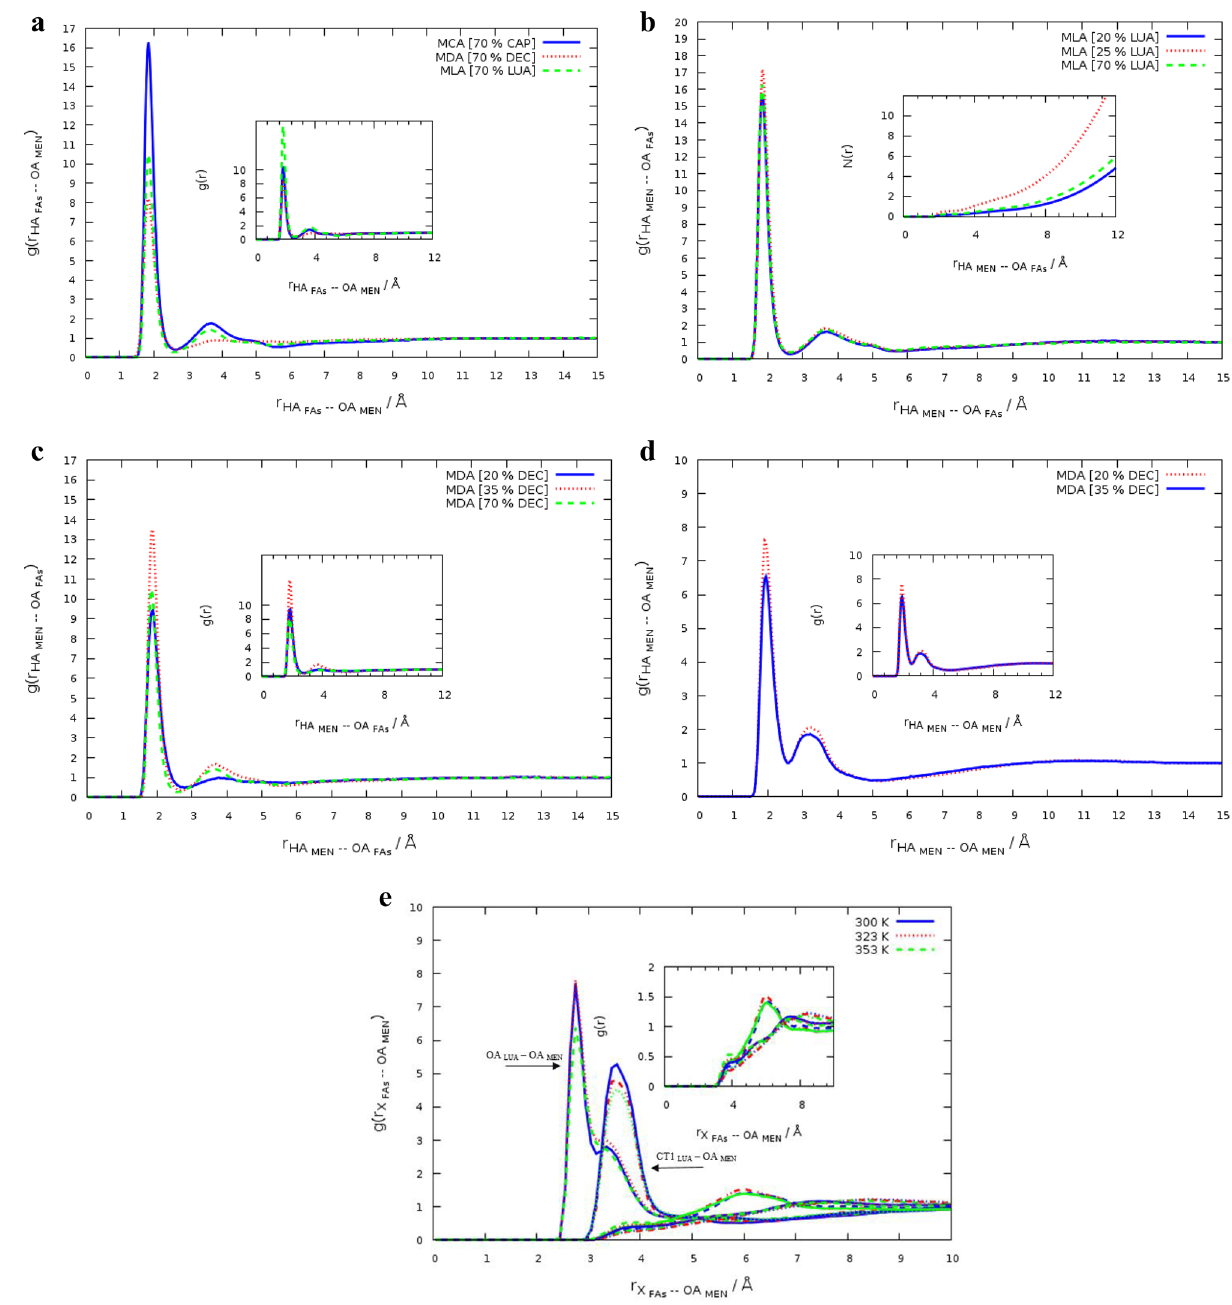
Figure 2. Atom–atom RDFs for Fas–MEN, ( a ) RDFs between HA atom FAs and the OA atom on the menthol molecules in the binary mixtures with %FAs = 70 at 323 K, ( b ) RDFs between HA atom on the menthol molecules and the OA atom of LUA in the binary mixtures with % LUA = 20, 25, and 70 at 323 K, ( c ) RDFs between HA atom on the menthol molecules and the OA atom of DEC in the binary mixtures with % DEC = 20, 35, and 70 at 323 K, ( d ) RDFs between menthol molecules, g(r) MEN–MEN , for the binary mixtures of MEN and DEC with % DEC = 20 and 35 at 323 K, ( e ) Site–site RDFs between atoms of the LUA molecules and the OA on the menthol molecule in the binary mixtures at 323